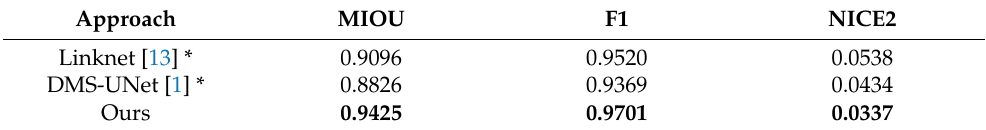
Table 7. Comparison with other networks on the CASIA-V4.0 database.